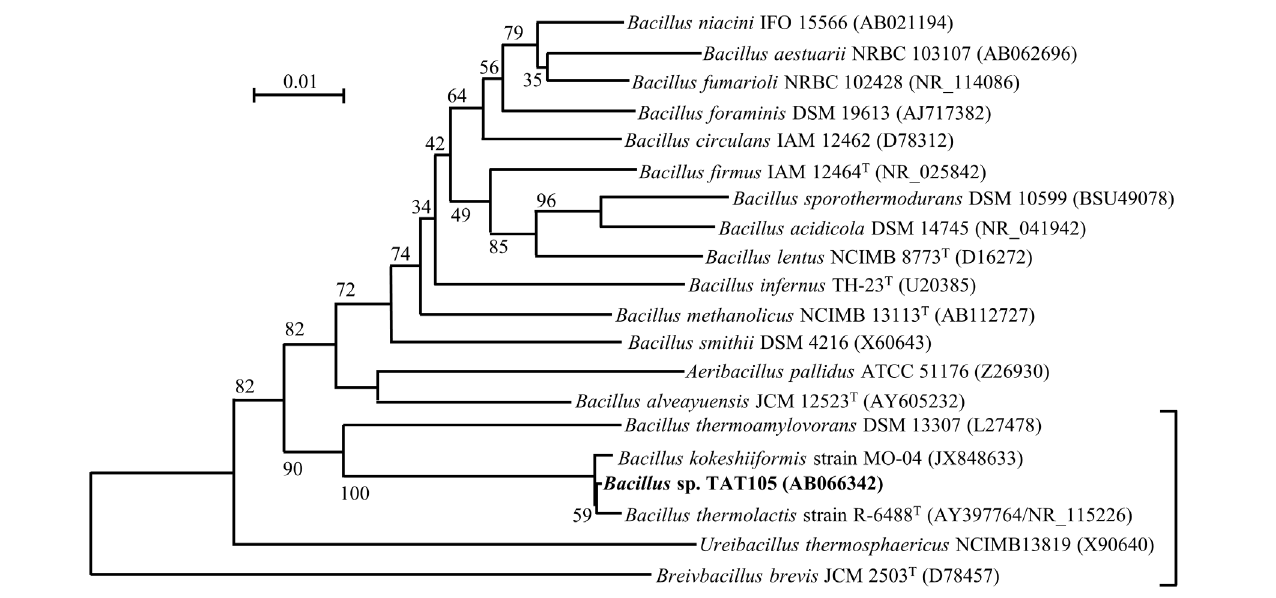
Figure 1. Phylogenetic tree comprising Bacillus sp. TAT105 and existing species in the genus Bacillus and related genera based on 16S rDNA se- quence data. The scale bar indicates 0.01 substitutions per nucleotide position. Accession numbers of sequences in the International Nucleotide Sequence Database Collaboration (INSDC) are shown in parentheses. The region indicated by the bracket on the lower right corresponds to the tree shown in Figure